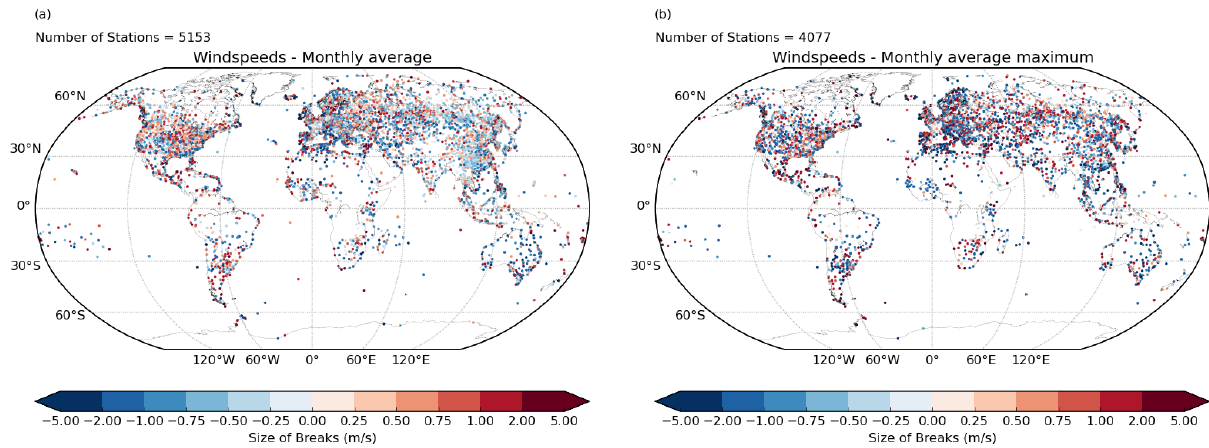
Figure 14. As for Fig. 6 but for (a) monthly-average wind speeds and (b) monthly-average daily-maximum wind Fig. 14. As for Fig. 6 but for (a) monthly average wind speeds and (b) monthly average daily maximum wind speeds.